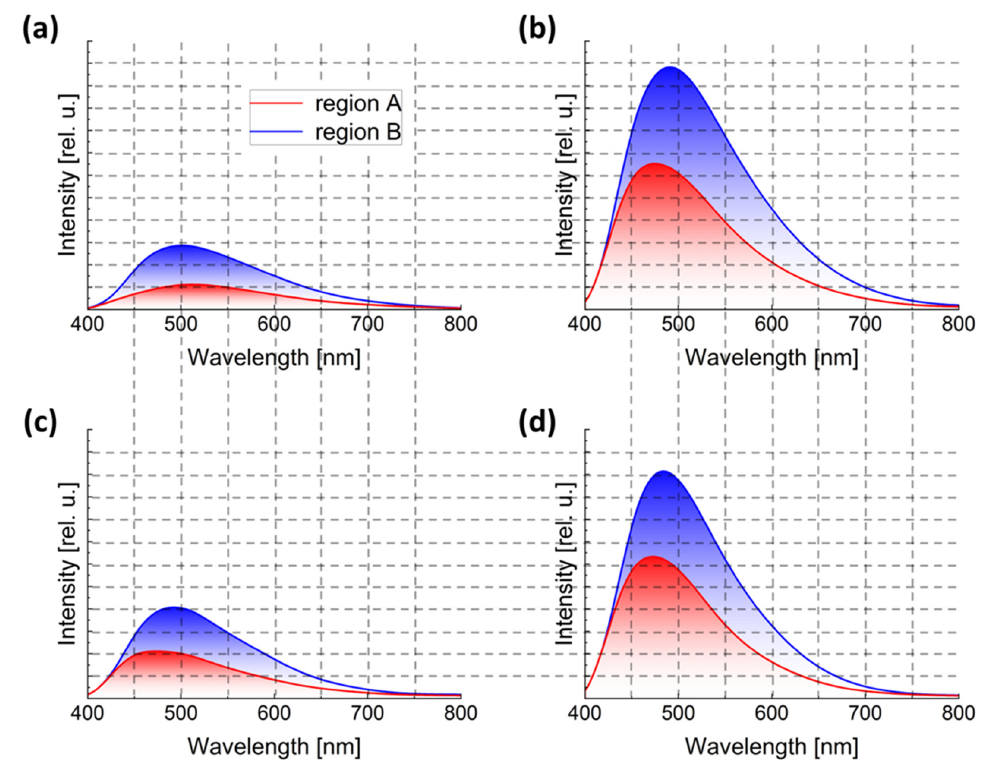
Figure 7. PL spectra in region A (red line) and B (blue line) obtained by averaging over an area of 50 × 50 µm 2 in all samples. Spectra are normalized on measurement integration time (see Table 1). ( a ) cellulose spin, ( b ) cellulose spray, ( c ) PLA spin, ( d ) PLA spray.